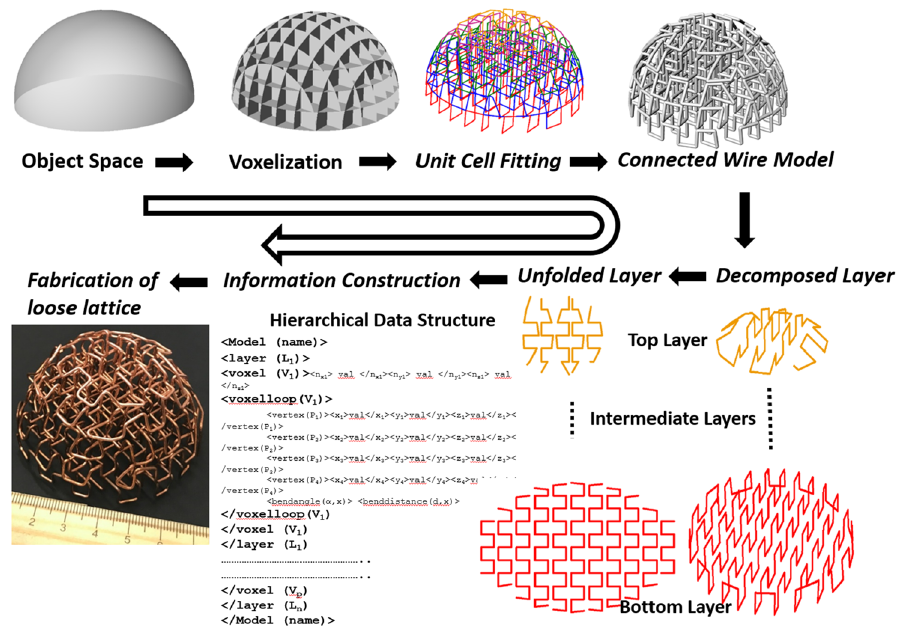
Figure 2. Construction of loose lattice structure with continuous wire bending